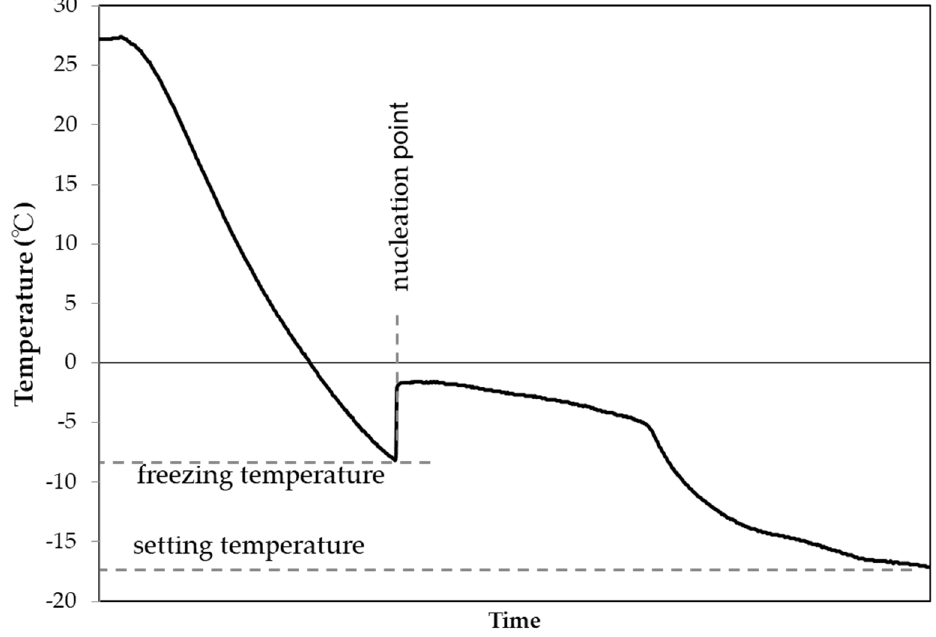
Figure 1. Typical sample temperature profile from room temperature to freezing.